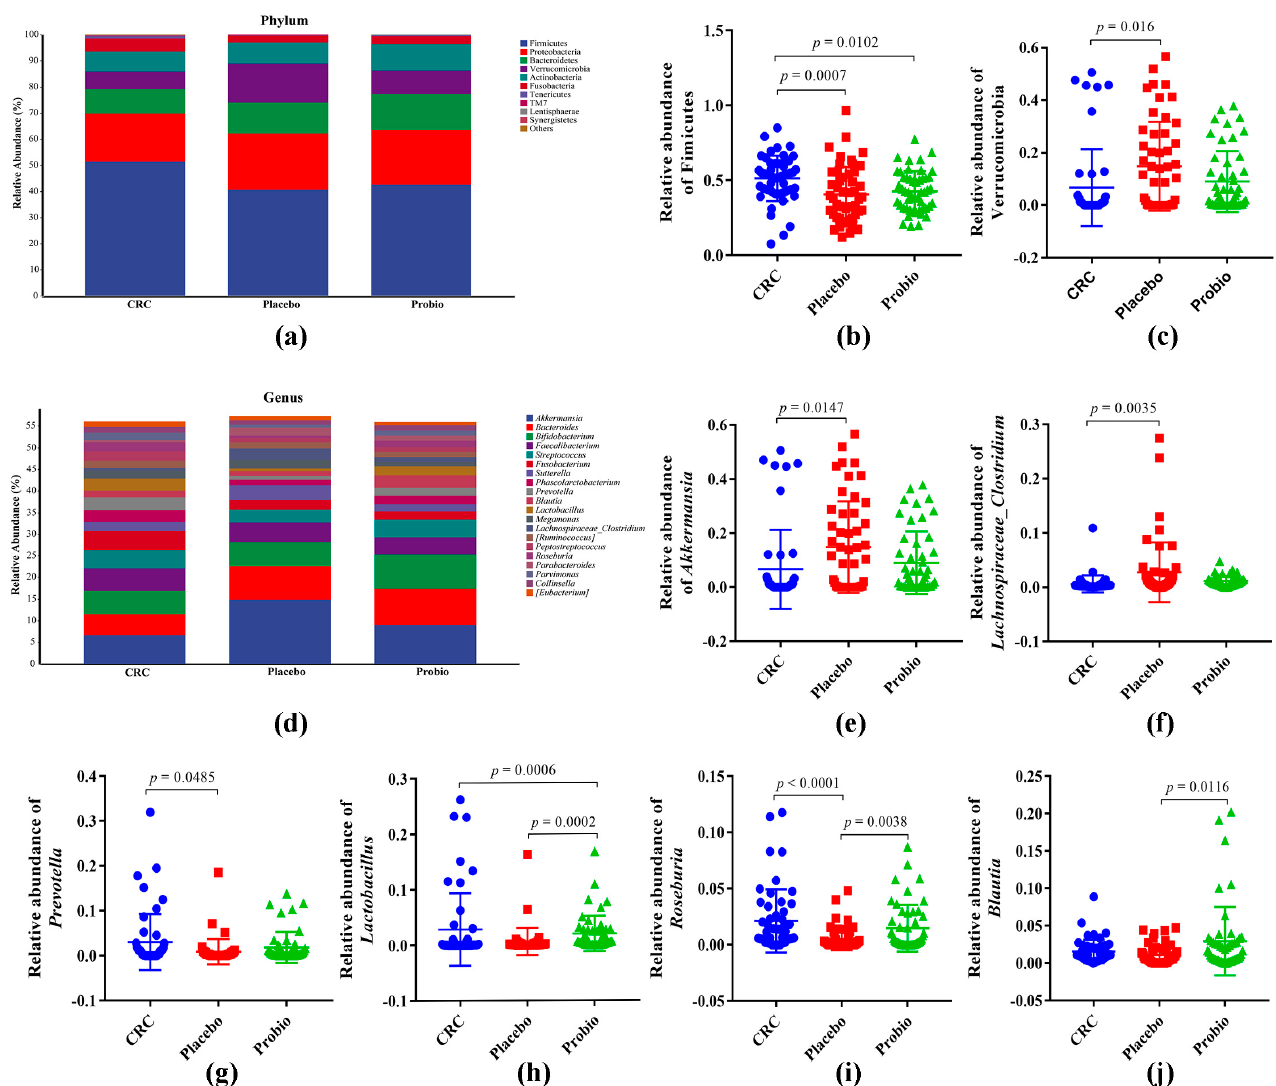
Figure 3. Probiotics combination remodeled the different gut microbial taxa among CRC patients. ( a ) Stacking map of taxa distribution at the phylum level. ( b , c ) The relative abundance of Firmicutes and Verrucomicrobia at the phylum level. ( d ) Stacking map of species distribution at the genus level. ( e , f ) The relative abundance of Akkermansia ( e ), Lachnospiraceae_Clostridium ( f ), Prevotella ( g ), Lactobacillus ( h ), Roseburia ( i ), and Blautia ( j ). CRC, the standard reference group before anticancer treatment. Placebo, the control group taking placebo. Probio, the treatment group taking probiotics combination. One − way ANOVA Multiple comparision was based on Kruskal − Wallis test following Dunn’s test. p value < 0.05 means statistical significance.